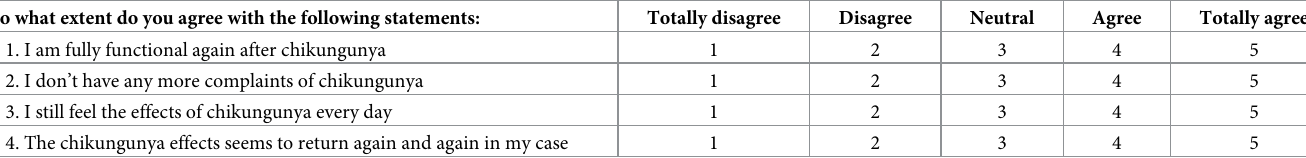
Table 1. CLTCS-score assessment instrument. To what extent do you agree with the following